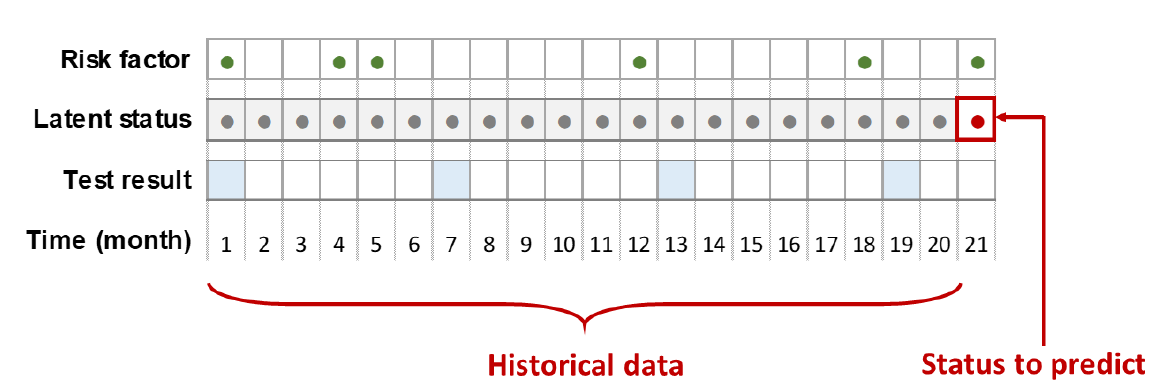
Figure 1 – Conceptual representation of the implementation of a surveillance programme within a herd. The focus of the model is the latent status regarding infection, which is modelled at the herd-month level. This status partly depends on risk factors and de- termines test results. In this diagram, risk factors are represented as green dots when present and available test results as blue shaded squares. The model predicts a proba- bility of infection for the most recent month in the surveillance programme using all the data collected for the estimation of model